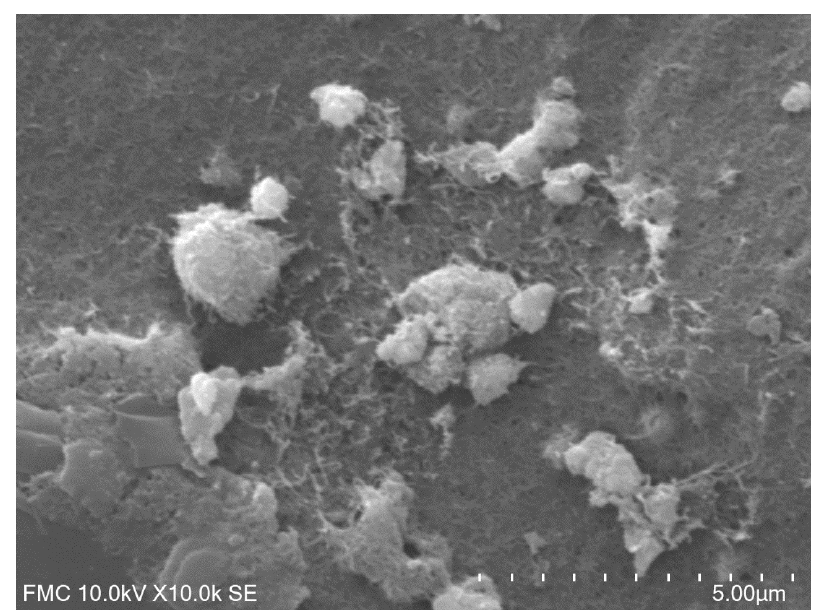
Figure 1. Scanning electron microscope (SEM) image of CSPEmodified with tyrosinase/platinum